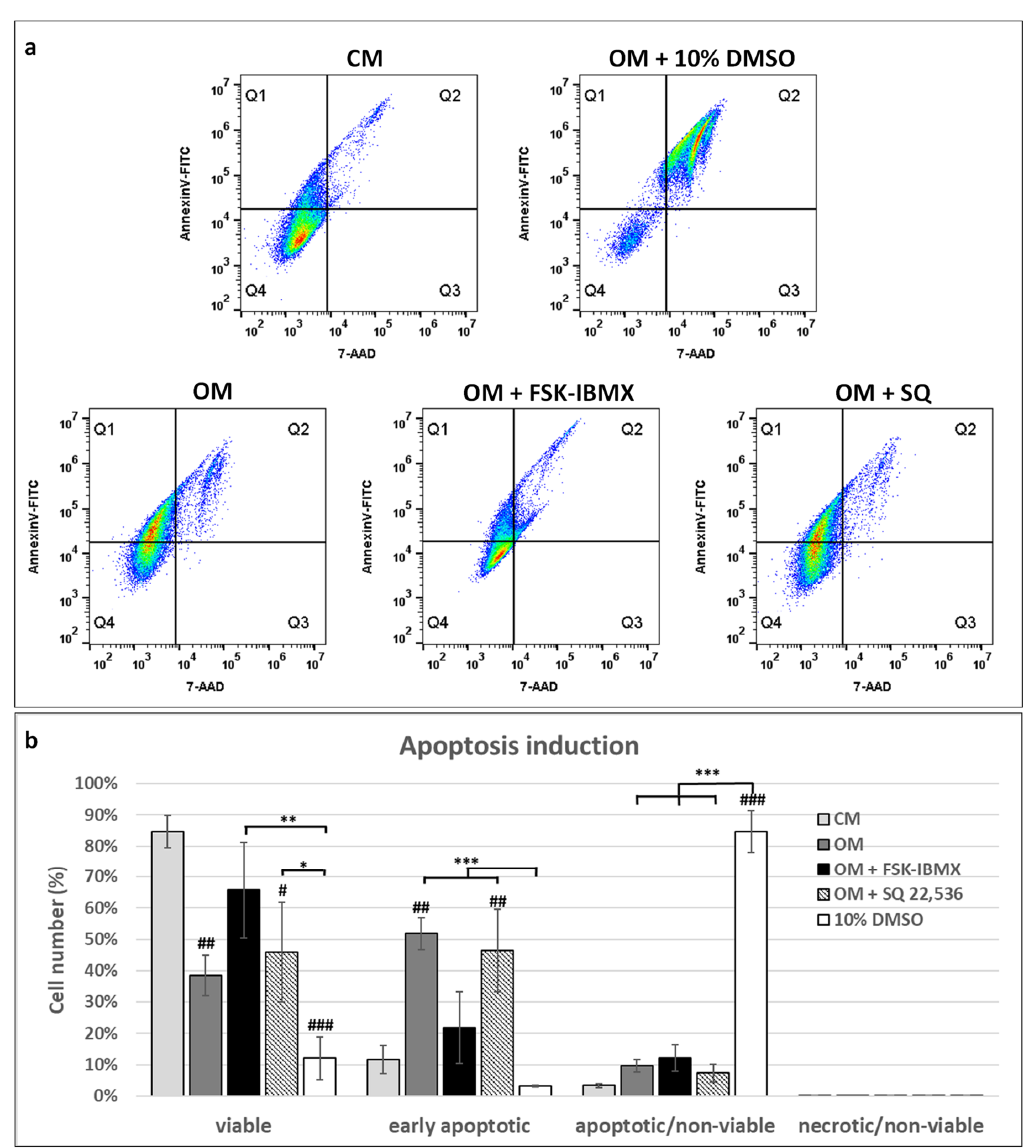
Figure 4. Effect of cAMP pathway regulation on apoptosis. Cells cultured in OM and treated with Figure 4. E ff ect of cAMP pathway regulation on apoptosis. Cells cultured in OM adenylate cyclase activator forskolin (FSK, 10 nM) and phosphodiesterase inhibitor 3-isobutyl-1- methylxanthine (IBMX, 500 nM) or with adenylate cyclase inhibitor SQ 22,536 (100 nM) for 72 h. Cells cultured in CM and OM with 10% DMSO were used as a reference for low and high apoptosis,